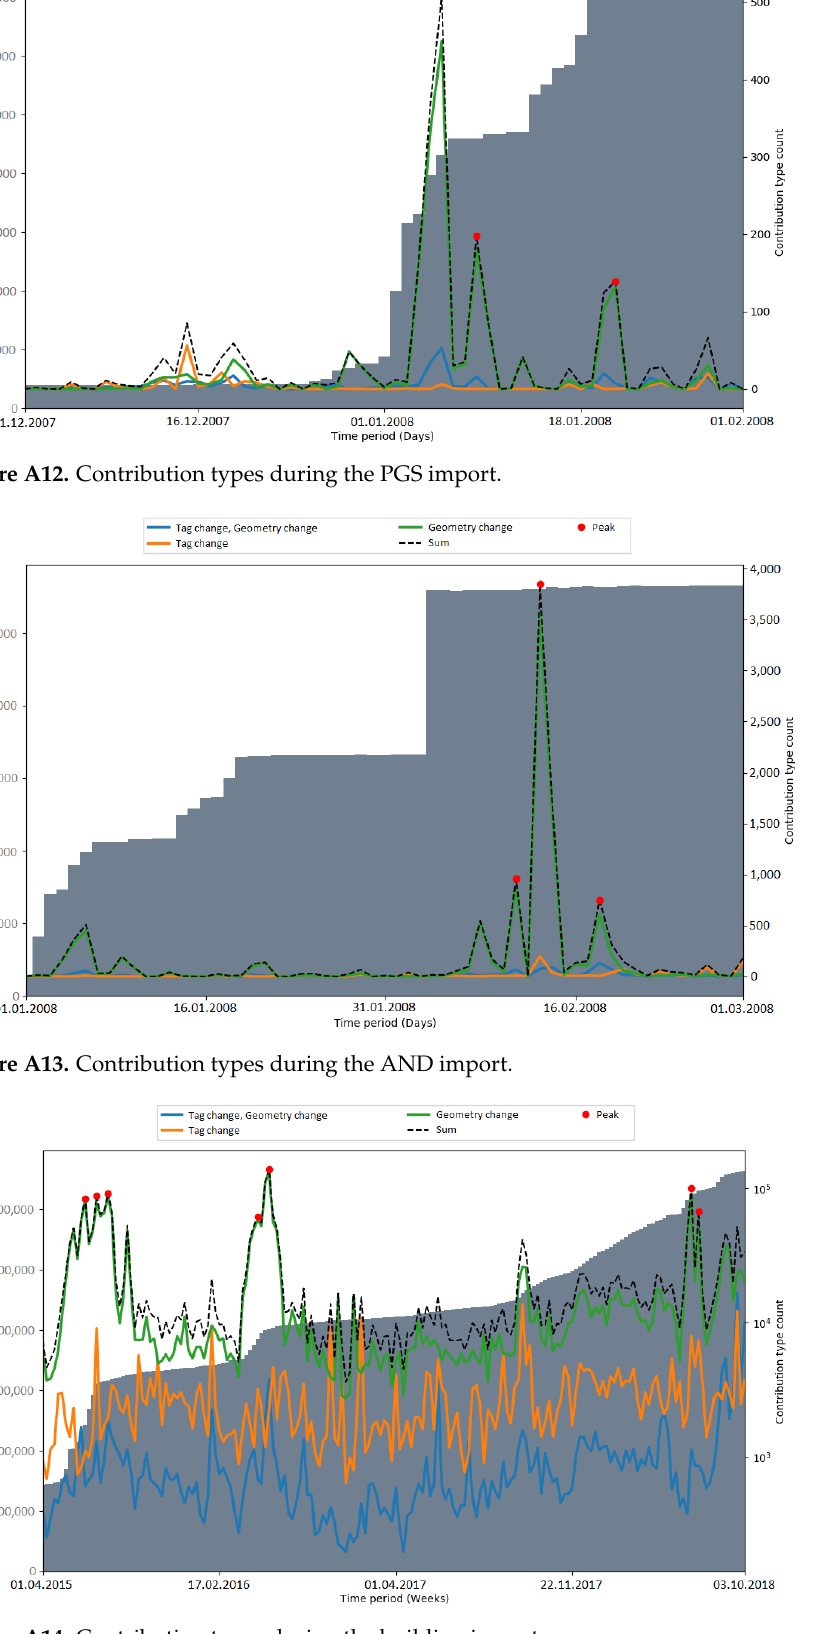
Figure A14. Contribution types during the building